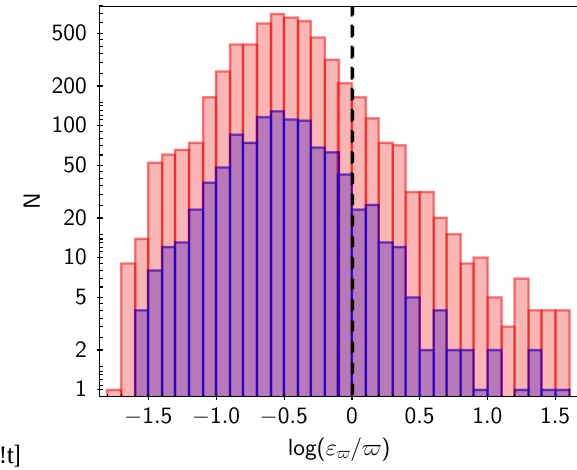
Figure 1. Distribution of the relative errors of TGAS parallaxes (only for ϖ > 0) for probable (light red histogram) and definite cluster members (violet histogram). The black vertical dashed line marks relative errors of ε / ϖ = 1. Stars that we considered to have reli- ϖ able parallaxes (see Sect. 2.2) are located left of this line. Table 1. Summary on data used for comparison.